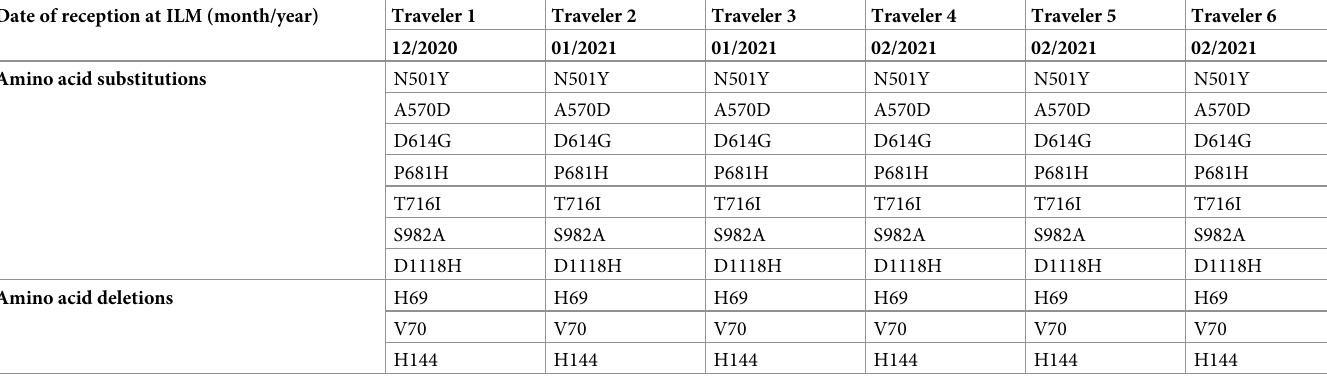
Table 2. Mutations specific to the Alpha variant detected in the S gene of SARS-CoV-2 strains isolated from self-collected samples of 6 travelers. Date of reception at ILM